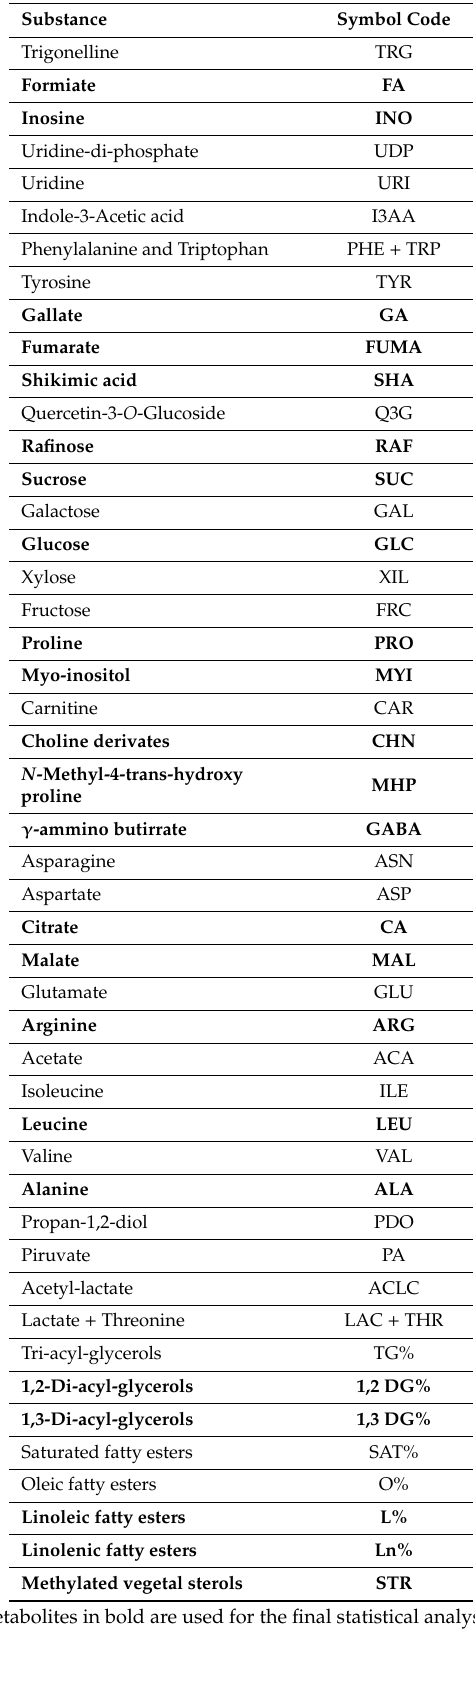
Table 1. List of abbreviations for compounds contained in pistachio seeds and found in the PWS (hydrophilic phase) and in PO (hydrophobic phase), the detailed features are reported in Table A1 in the Appendix